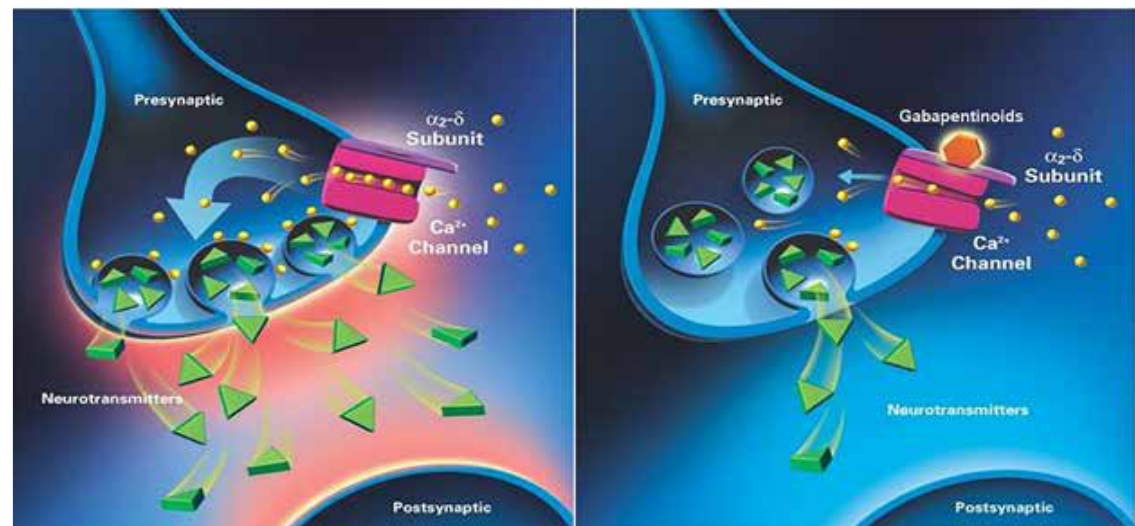
Figure 1: A hyperexcitable neuron associated with neuropathic pain (left pane). Binding of the gabapentinoids to the alpha 2-delta subunit of the calcium channel reduces the neuron’s excitability by attenuating neurotransmitter release (Adapted from Shim 11 ). -δ subunit - Alpha 2-delta subunit α 2 Ca 2+ channel - Calcium